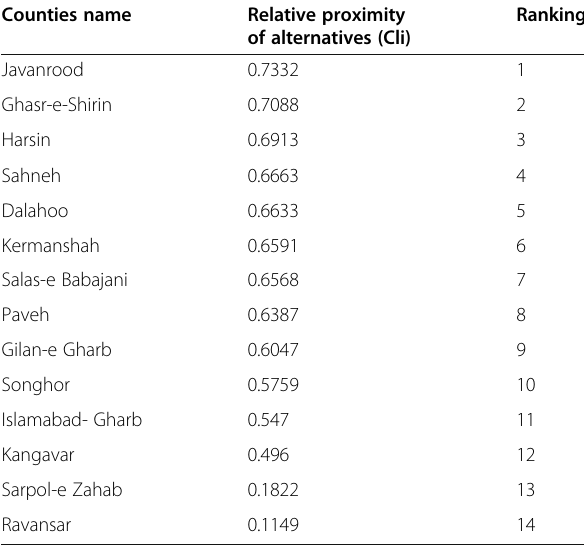
Table 7 Township rankings using